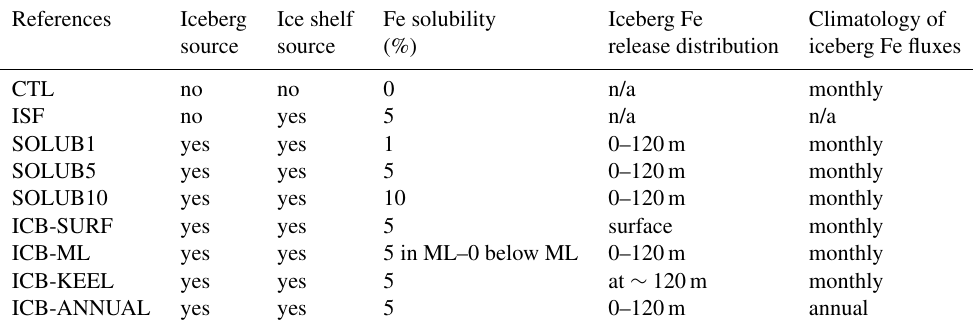
Table 2. Description of model experiments. The ice shelf Fe supply is uniformly distributed over the depth and width of the unresolved cavities, from the mean ice front base down to the seabed or the grounding line depth if shallower, following the parameterization of Mathiot et al. (2017). The climatology of ice shelf Fe fluxes is